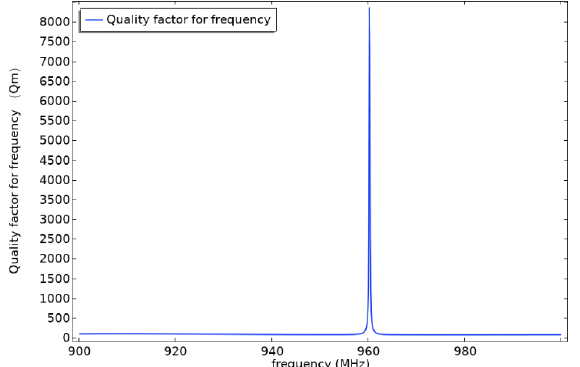
Q -parameter analysis curve. Figure 9. m Q Figure 9. Q m -parameter analysis curve. -parameter analysis curve. Figure 9. m